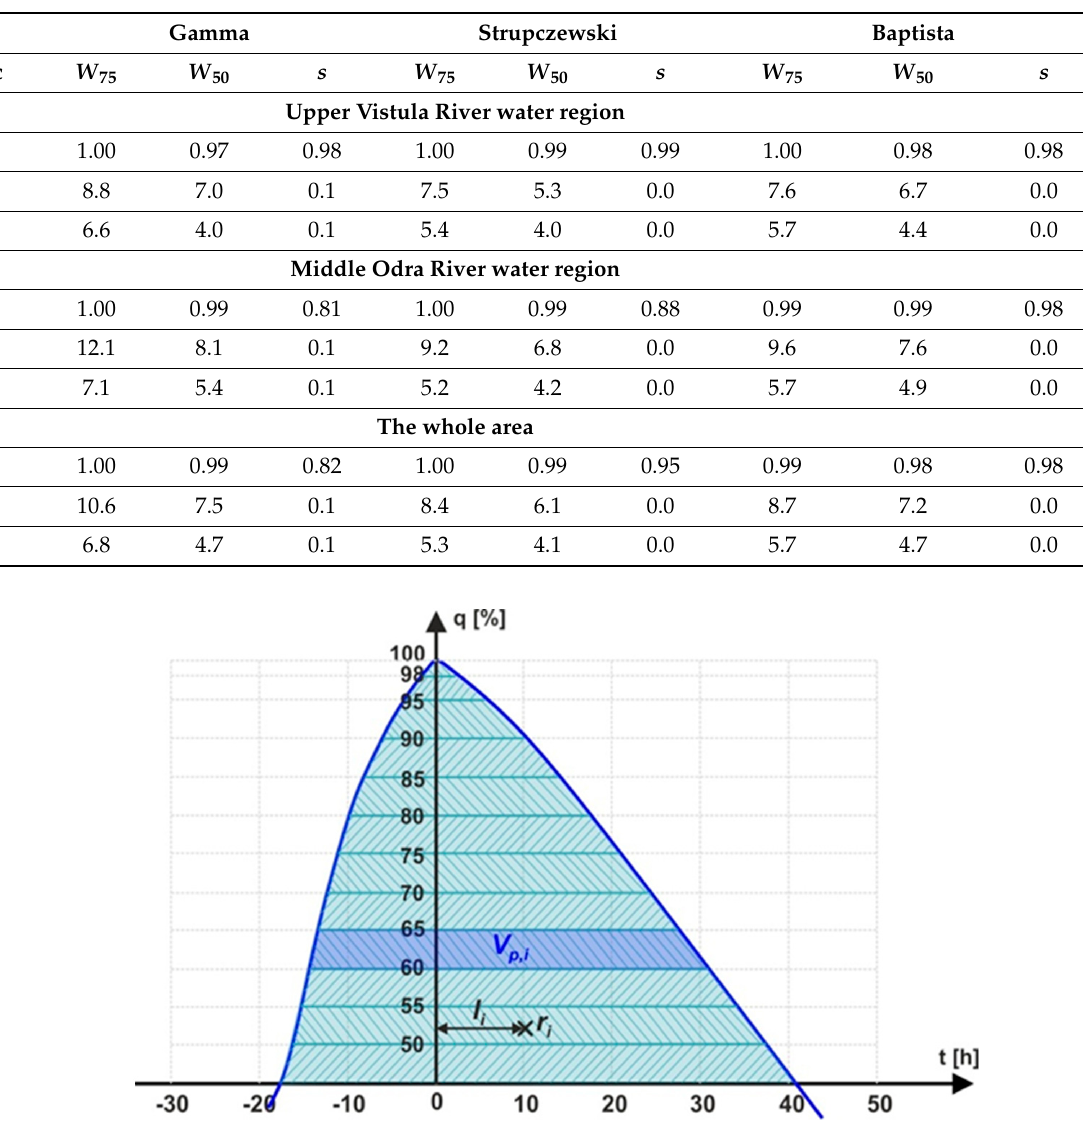
Figure 8. Development of partial volume of hydrograph (trapezoid area) and the center of gravity for time coordinate. Figure 9 shows correlation plots between the values of the gravity centers estimated from the parametric hydrograph versus nonparametric hydrograph developed with the Archer method ( r ar ) for W 50 ( r 50% ) and W 75 ( r 75% ). The obtained results indicate that Strupczewski and Baptista distribution methods provided a very good fit, outperforming Gamma distribution at both truncation levels, p = 50% and p = 75%. The coefficient of determination R 2 was 0.937 for W 50 and 0.765 for W 75 in the Baptista model, while for the Gamma distribution, R 2 was 0.804 for W 50 and 0.617 for W 50